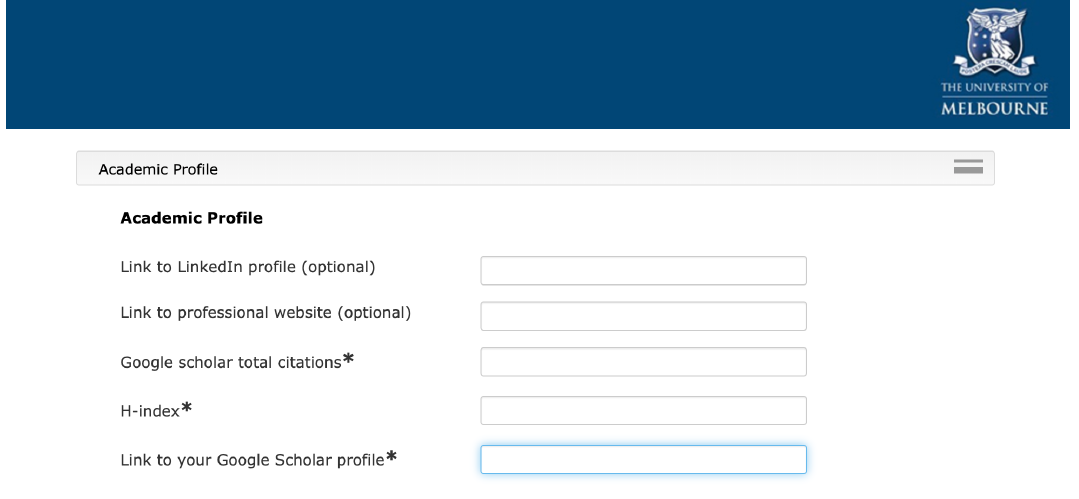
FIGURE 1: Google Scholar Metrics as compulsory inputs for Lecturer/Senior Lecturer (equivalent to Assistant Professor) job application in Information Systems at the University of Melbourne (recorded 17 October